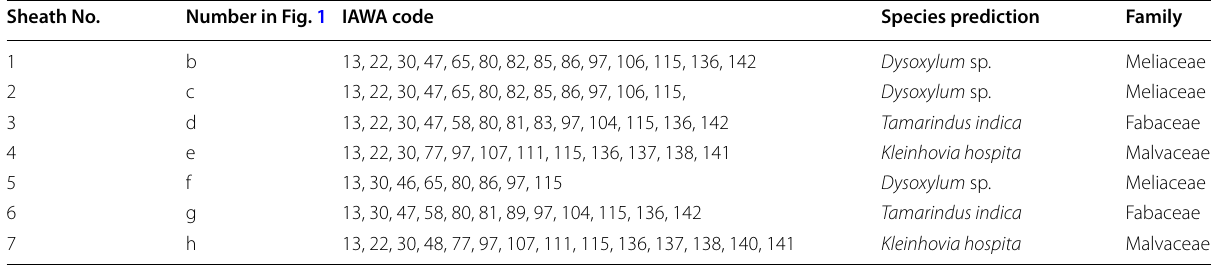
Table 1 Identification results of likely species of wood used in the kris sheaths Sheath